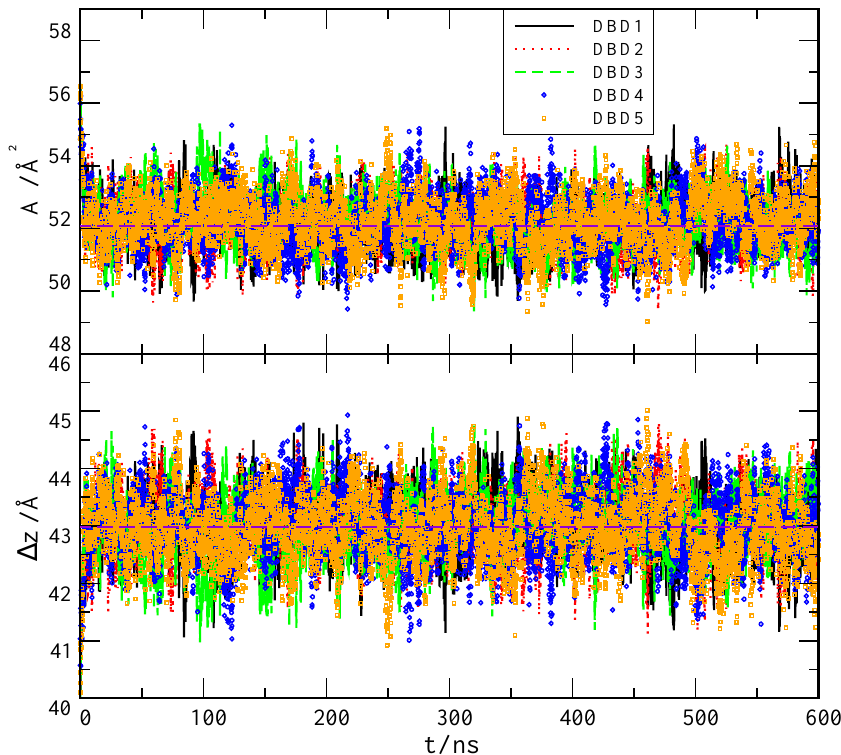
Figure 2. Area per lipid A and thickness ∆ z of the membrane systems including DBD derivatives as a function of simulation time t . DBD1 (continuous line); DBD2 (dotted line); DBD3 (dashed line); DBD4 (circles); DBD5 (squares). Long-dashed (purple) lines indicate the average values reported in Table